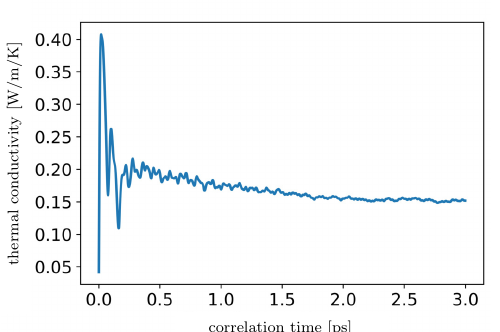
Figure 3. Thermal conductivity of silicone rubber at normal conditions as function of correlation time in picosecond.